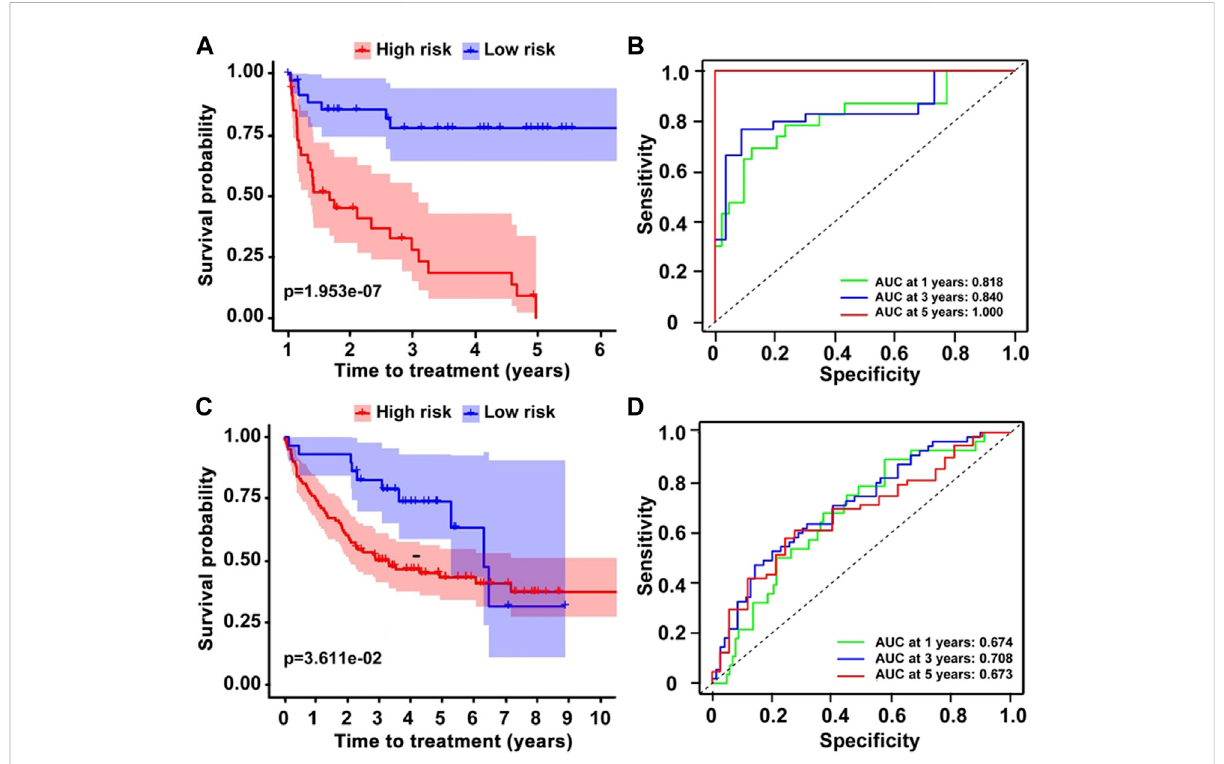
FIGURE 4 The prediction of TTT on CLL patients. (A,C) K – M survival curves showing the different TTT on two datasets and (B,D) ROC analysis for the prediction of